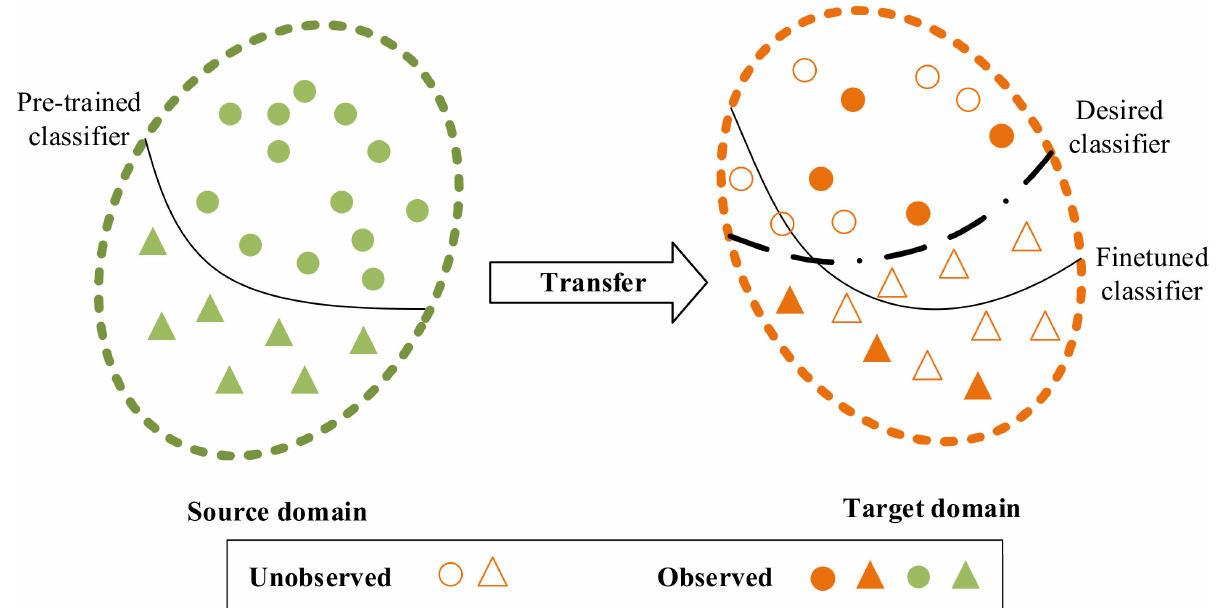
Figure 1. Illustration of negative transfer. The two oval dashed lines represent the distribution shape in the source and target domains. Transfer learning facilitates the training of a finetuned classifier in the target domain even with small samples, but distribution discrepancy may cause negative transfer, leading to poor generalization in target